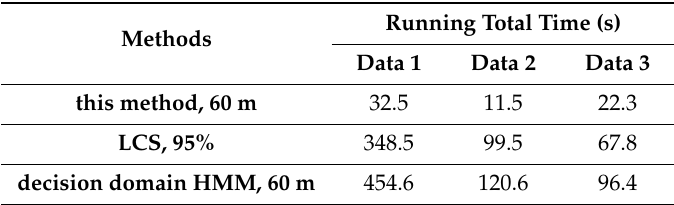
Table 2. Comparison of the efficiency of this method with the LCS method and the decision domain HMM method.